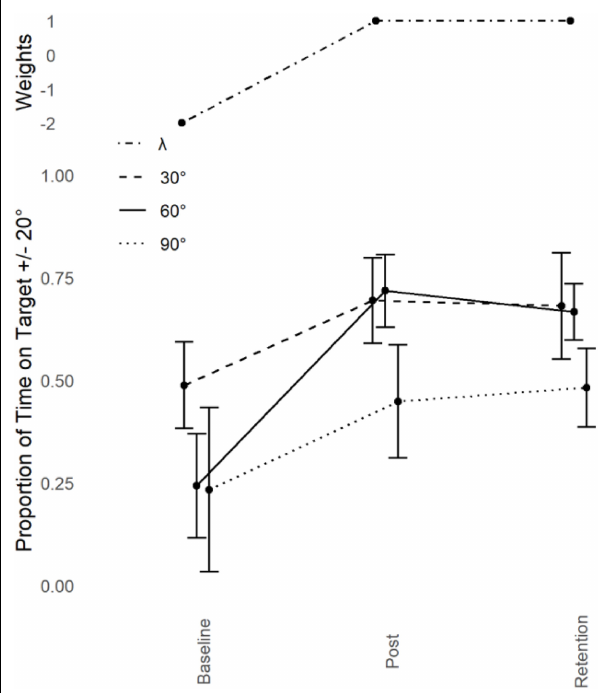
FIGURE 3 | Young adults trained at 60 ◦ : Judgement transfer. Average unperturbed Perceptual Judgement Thresholds for 60 ◦ (lower) with standard error bars at Baseline, Post Training, and Retention with corresponding Lambda ( λ ) weights (upper). Average unperturbed thresholds reduced as a function of training over time, indicating an improvement in performance. This improvement remained after the retention period.